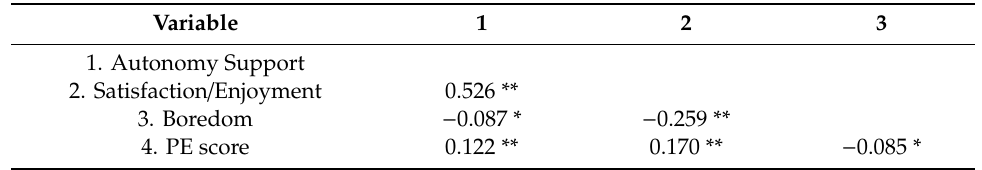
Table 4. Correlation